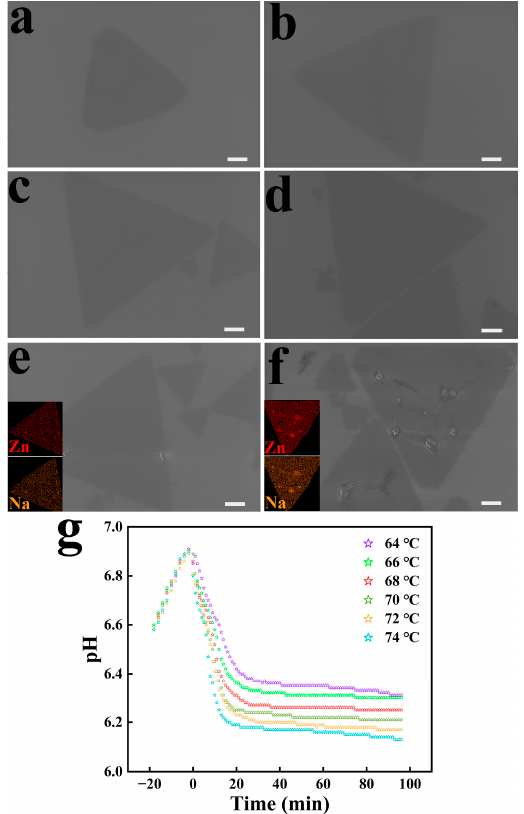
Figure 2. Controlling the growth of 2D ZnO by temperature. SEM images of 2D ZnO synthesized with the temperature at ( a ) 64 °C, ( b ) 66 °C, ( c ) 68 °C, ( d ) 70 °C, ( e , f ) 72 °C and 74 °C . Insets are